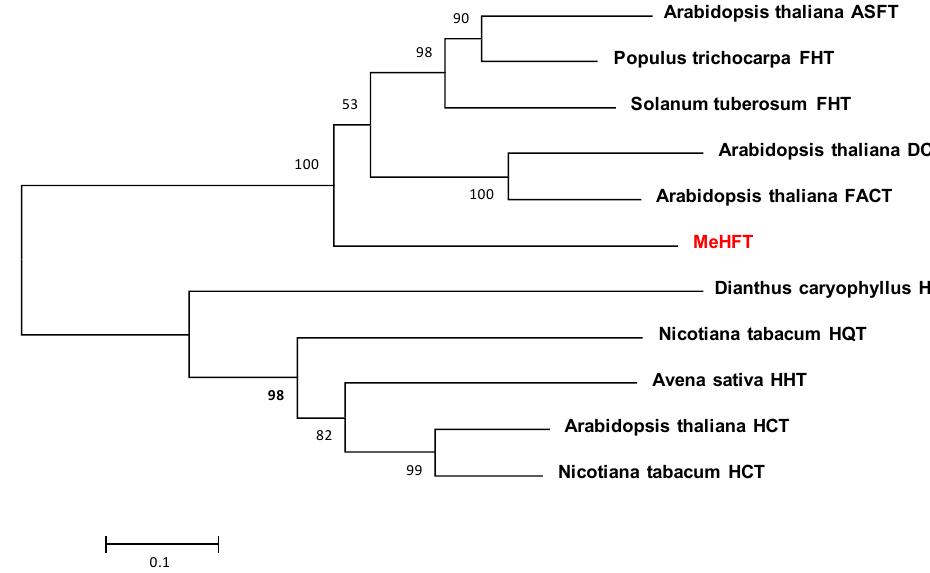
Figure 2. A phylogenetic analysis of MeHFT. The Uniprot accession numbers of the proteins included in the analysis are: Populus trichocarpa FHT (JX515962), Solanum tuberosum FHT (ACS70946), A. thaliana ASFT (AT5G41040), Dianthus caryophyllus HCBT (CAB06430), A. thaliana DCF (AT3G48720), A. thaliana FACT (AT5G63560), N. tabacum HQT (CAE46932), Avena sativa HHT (BAC78633), A. thaliana HCT (AT5G48930), N. tabacum HCT